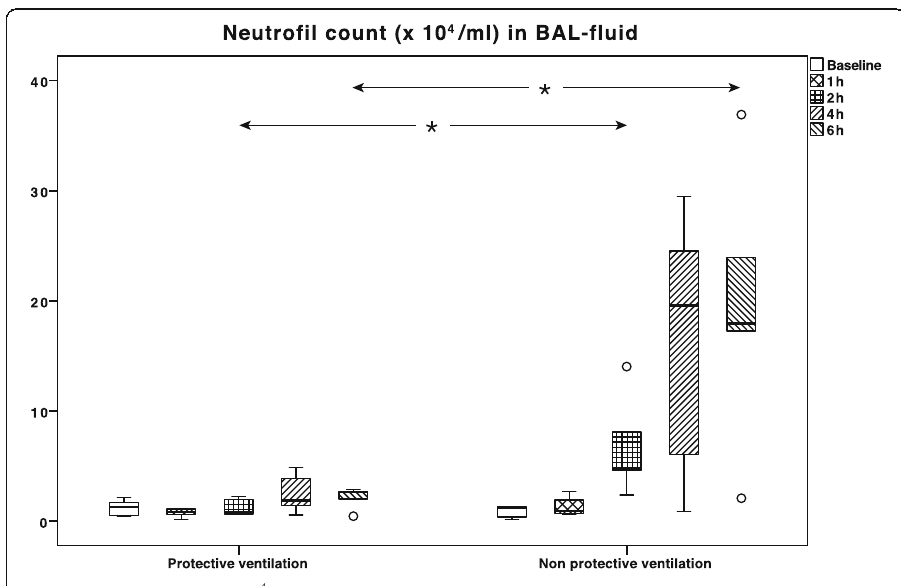
Fig. 3 Neutrophil count (× 10 4 /ml) in the bronchoalveolar lavage (BAL) fluid. The neutrophil count was significantly higher in the group receiving harmful ventilation at 2 h ( p <0.01) and 6 h ( p =0.03) of ventilation. Boxes indicate the second to third quartile with the median. Brackets indicate the min-max values, circles indicate outliers, and stars indicate significant differences ( p <0.05)